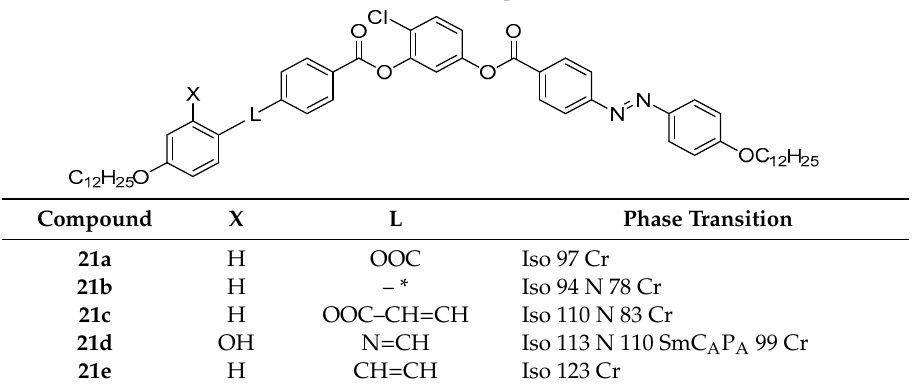
Table 5. Phase transition of compounds of series 21 .